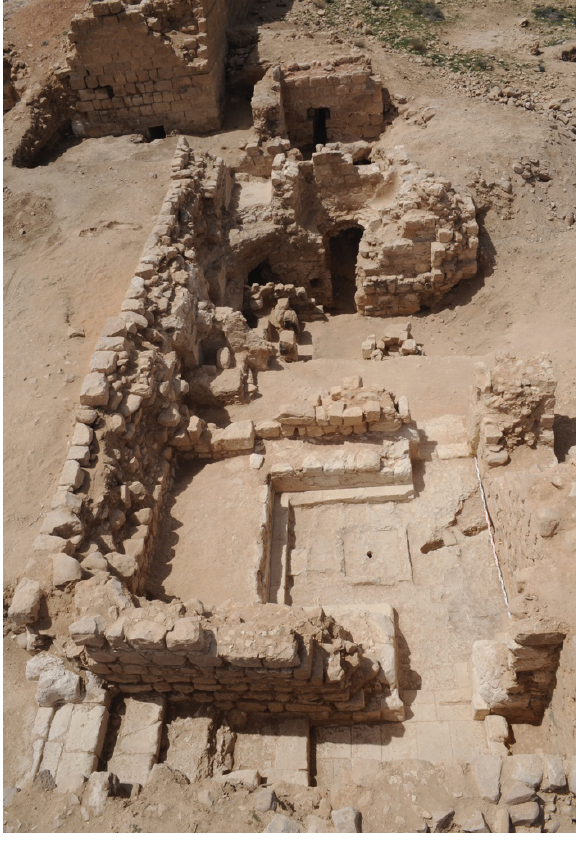
Figure 3: Bath Building (C)